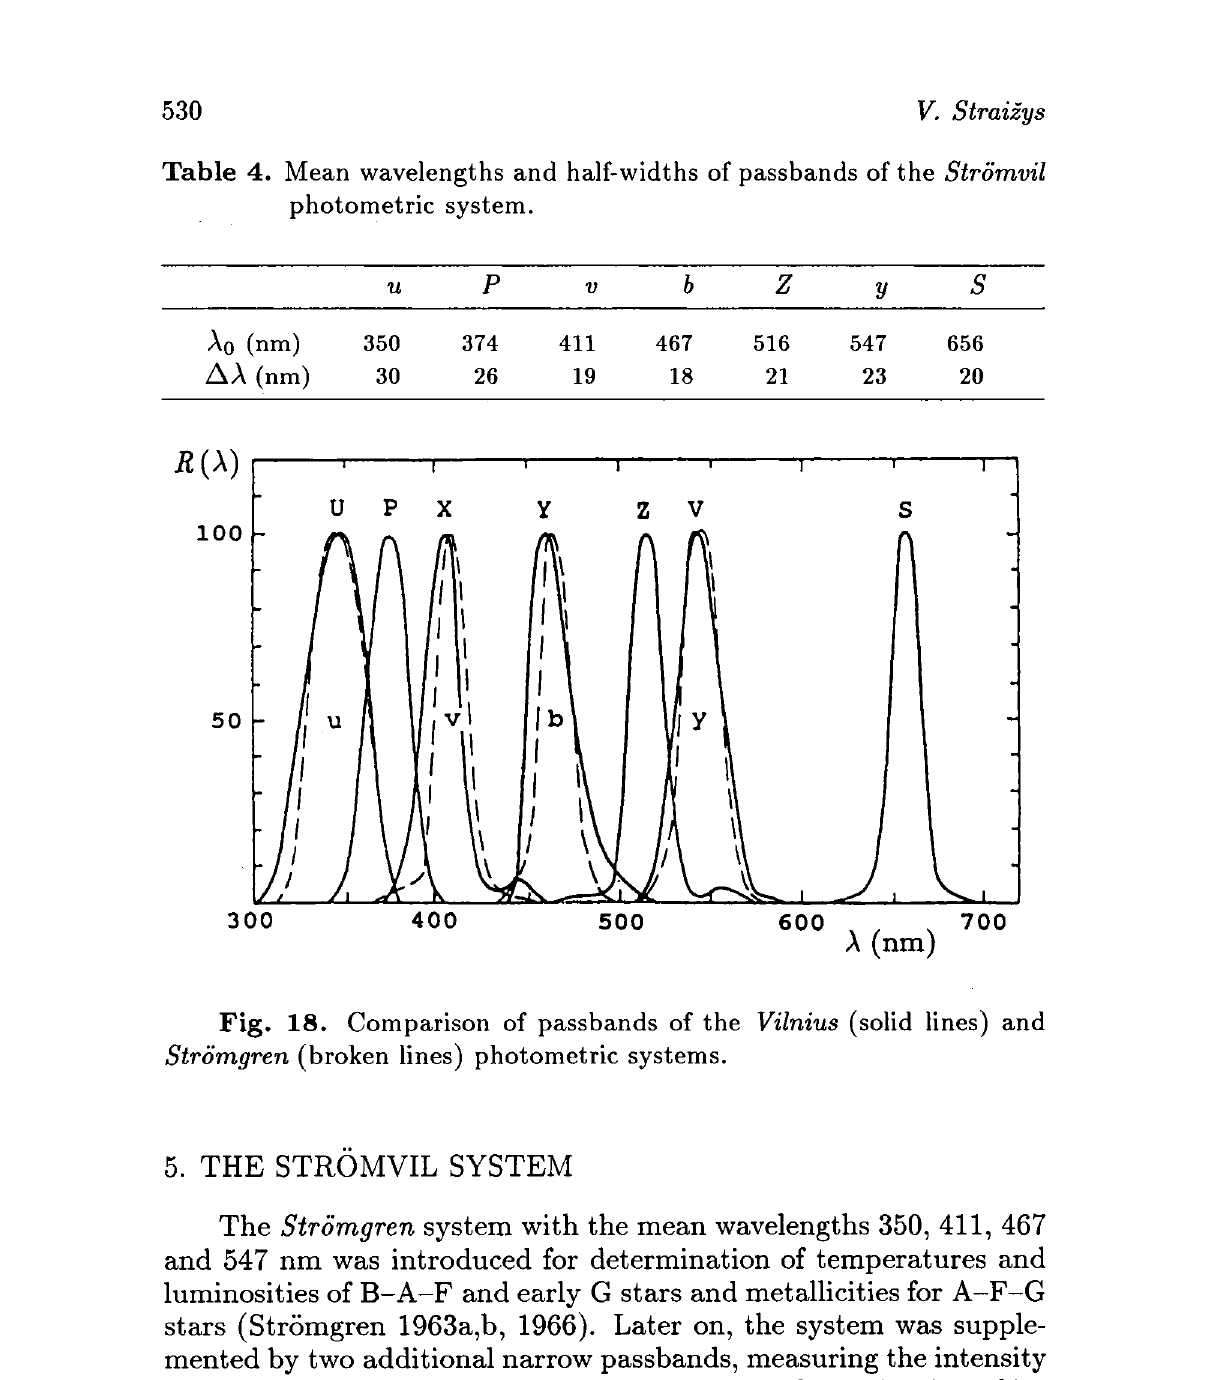
Fig. 18. Comparison of passbands of the Vilnius (solid lines) and Stromgren (broken lines) photometric